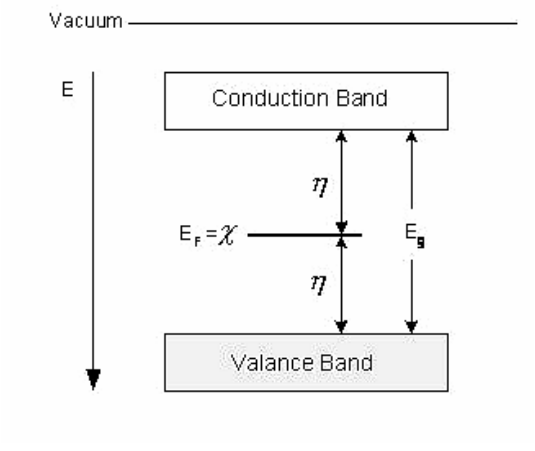
Figure 3. Schematic electronic structure of solid